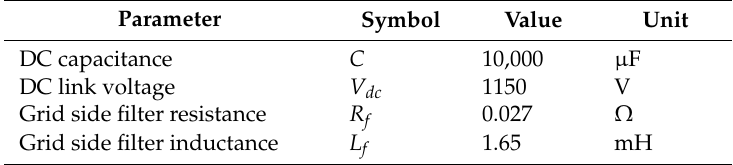
Table A3. Parameters of the power converter